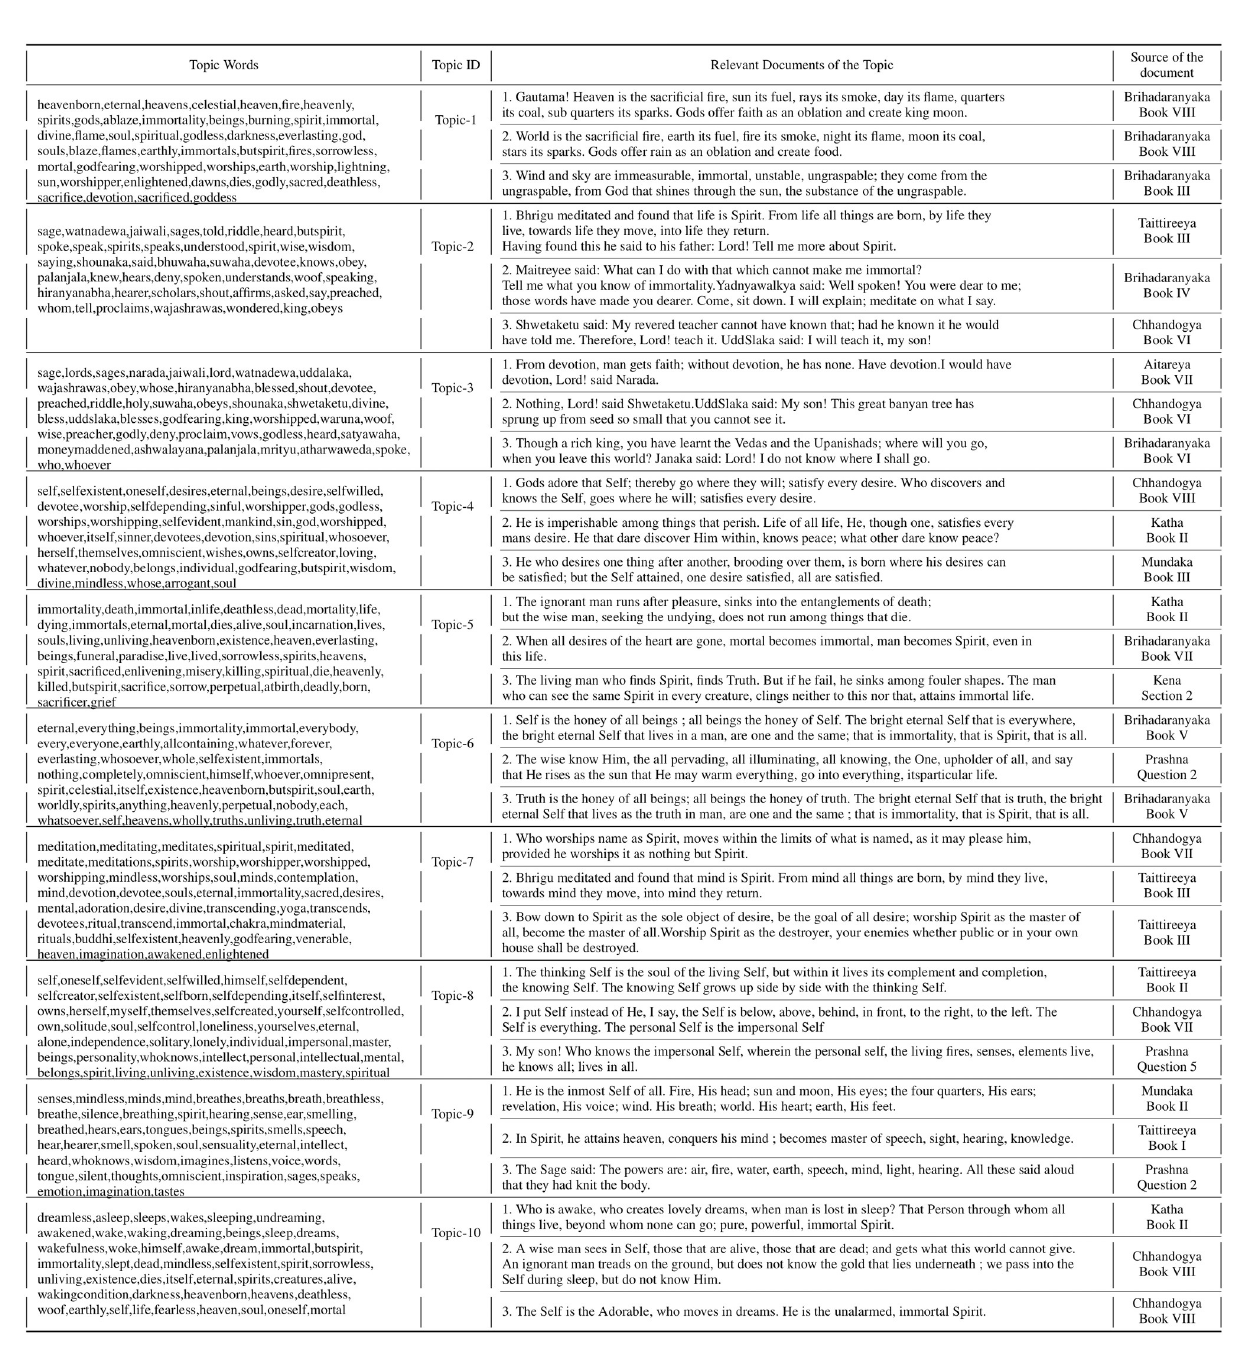
Fig 5. Topics of the Ten Principal Upanishads and some of their relevant documents(Model: USE-HDBSCAN-UMAP).